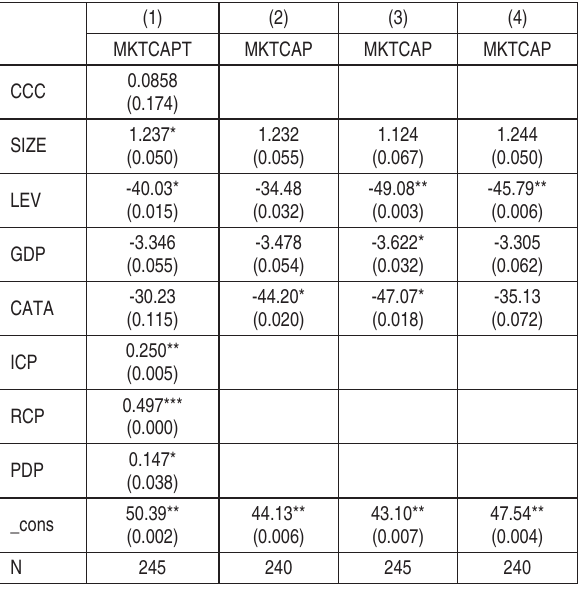
Table 6. Effect of WCM on firm value using ran- dom effect (RE) regression